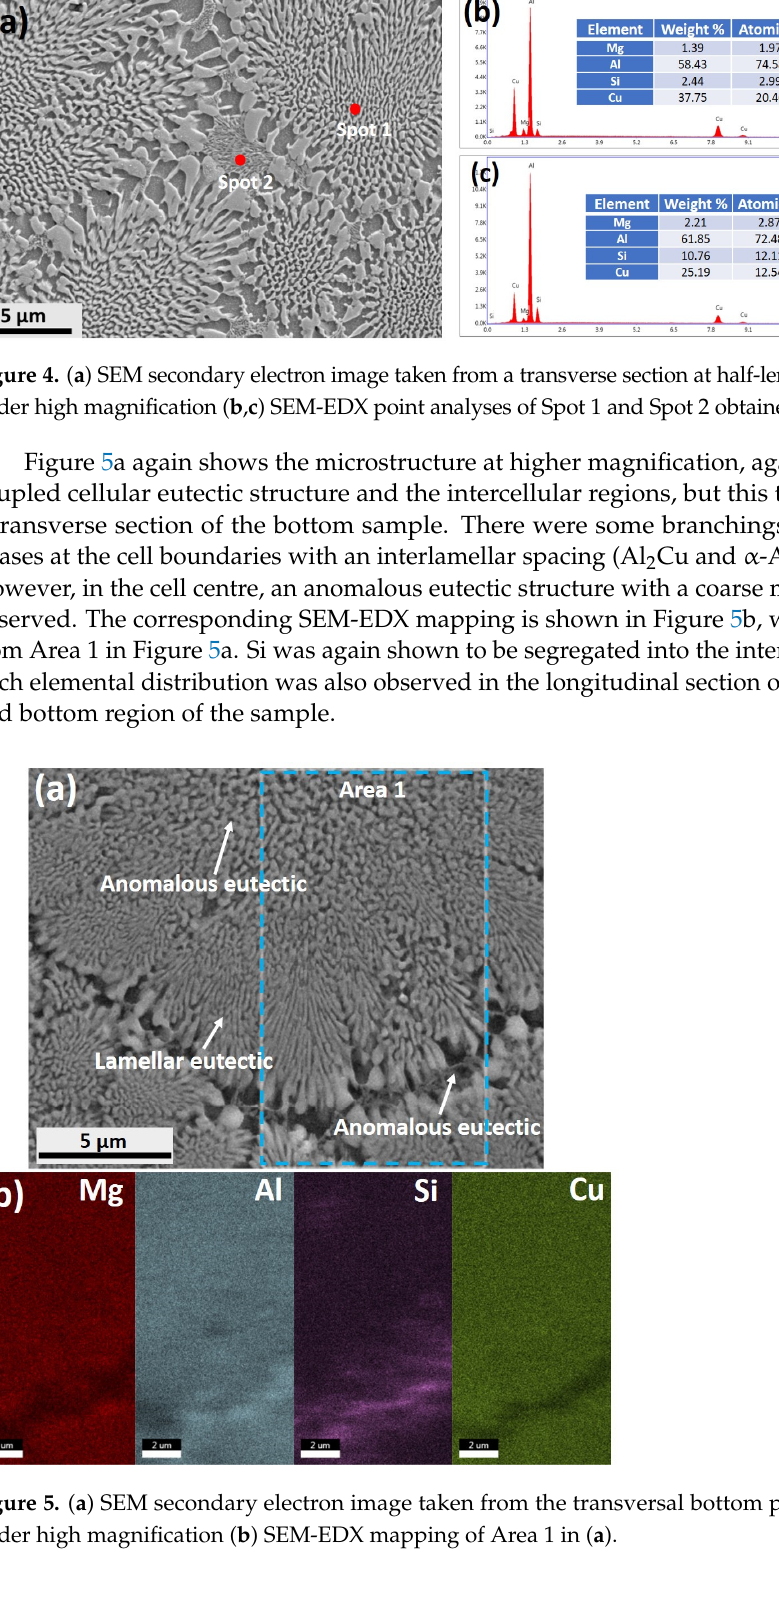
Figure 5. ( a ) SEM secondary electron image taken from the transversal bottom part of the sample under high magnification ( b ) SEM-EDX mapping of Area 1 in ( a